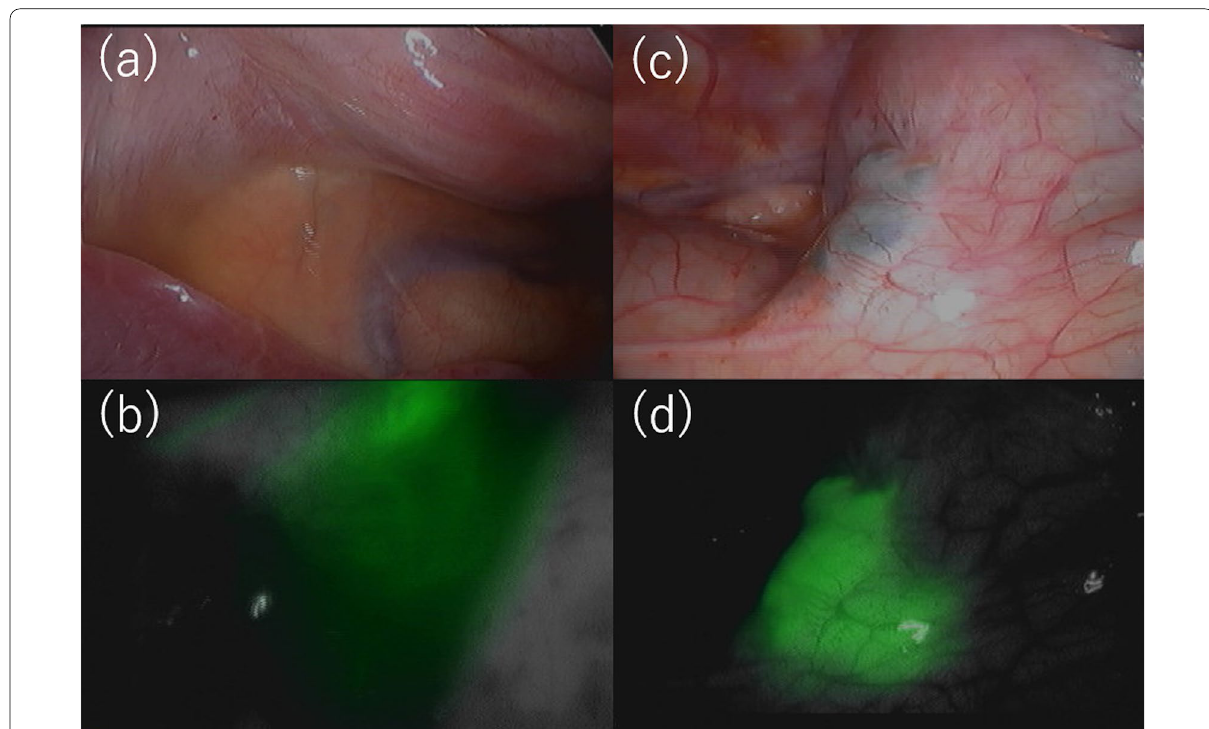
Fig. 2 Thoracoscopic findings. a The pleural fluid was not stained, but an infrared camera detected fluorescence in the pleural effusion ( b ). A cystic lesion was observed in which the pleura was thinned and dialysate was accumulated under the pleura at the central tendon of the diaphragm of the mediastinal angle ( c , d